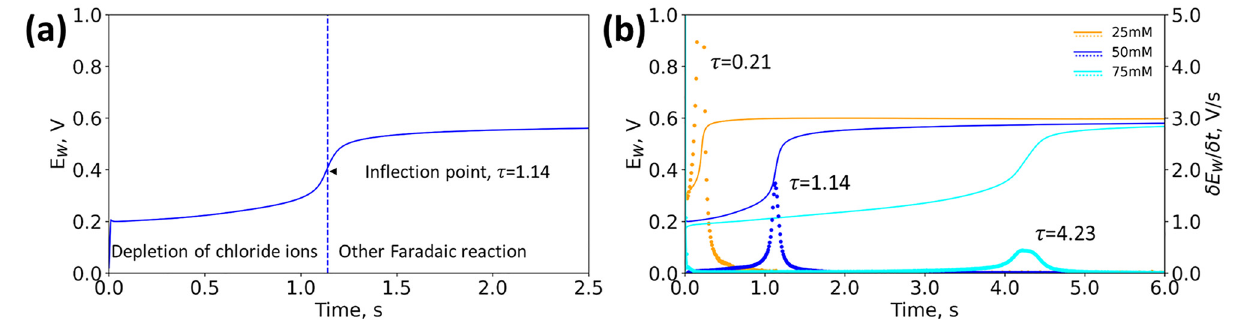
Figure 2. ( a ) Representative chronopotentiograms at 50 mM NaCl and 20 mM Na 2 SO 4 at 25 ◦ C in 240 A/m 2 . ( b ) The effect of concentration on the potential response and transition time at 25 ◦ C in 240 A/m 2 . The dotted line represents the derivative of the chronopotentiogram.